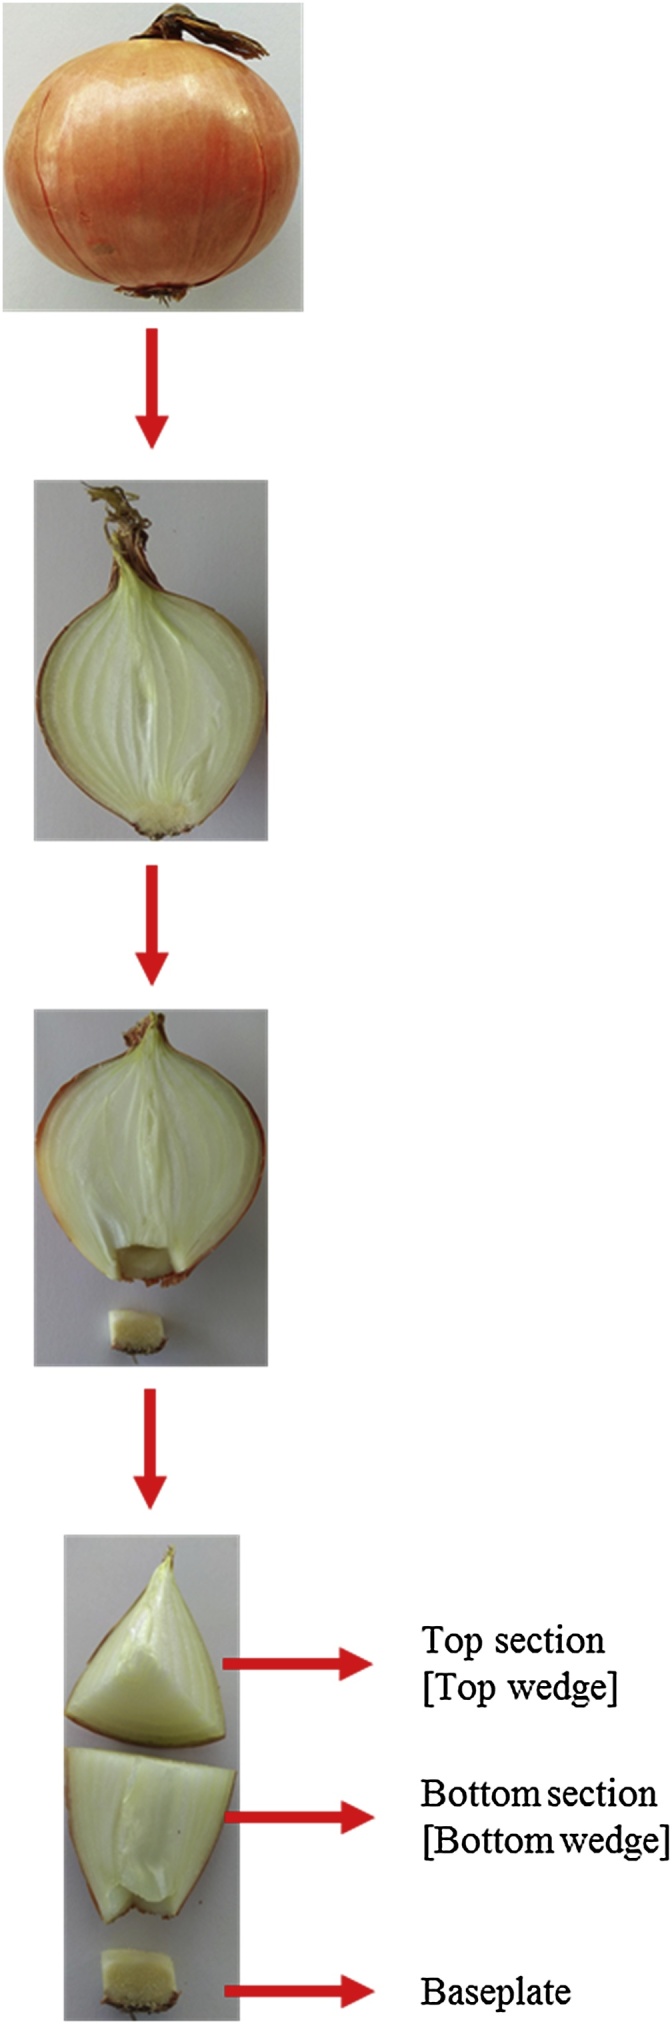
Onion bulb cut into top wedge, bottom wedge and baseplate.